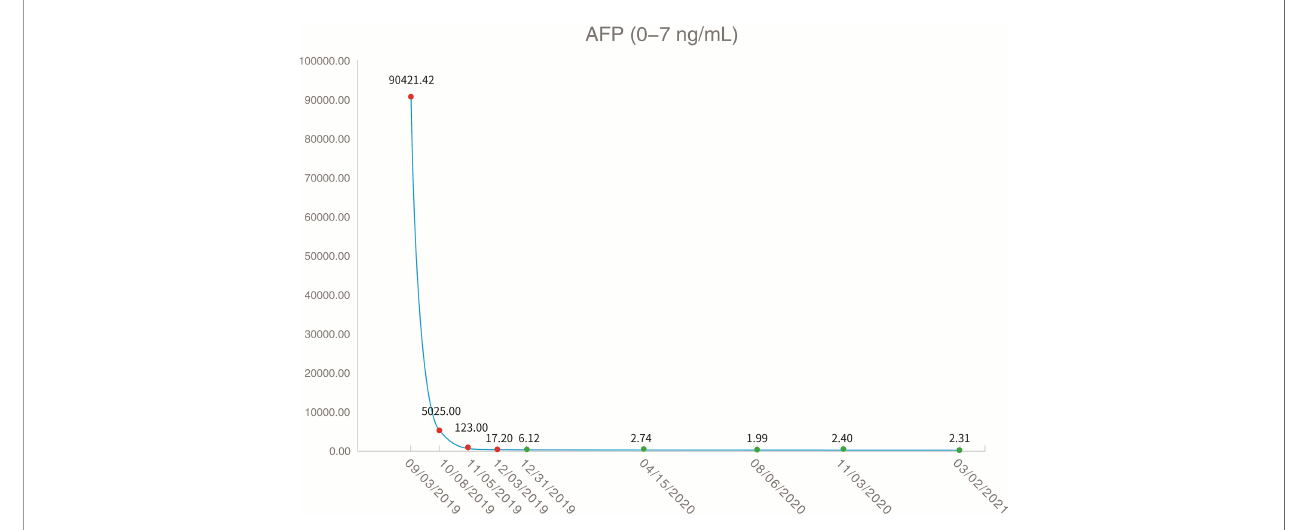
FIGURE 3 | Serum alpha fetoprotein levels throughout the treatment period (red dots indicate increased and green dots indicate normal